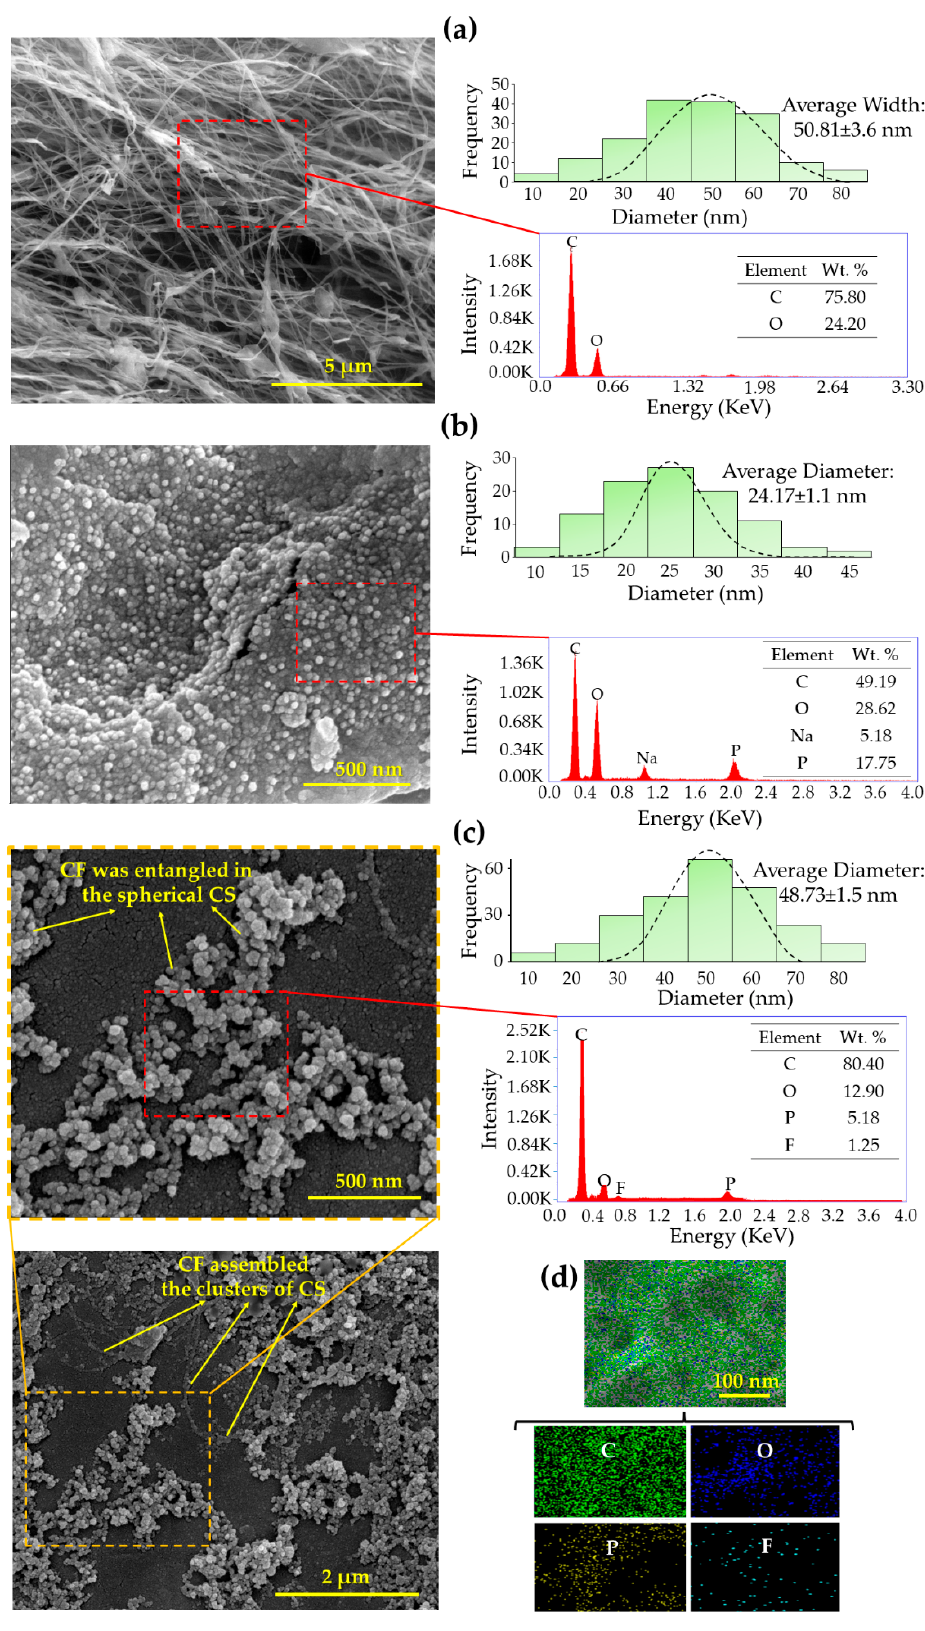
Figure 2. SEM image, the average diameter and EDX of ( a ) CF, ( b ) CS NPs and ( c ) CS-CF/5FU BNCs; ( d ) EDX layered image of CS-CF/5FU